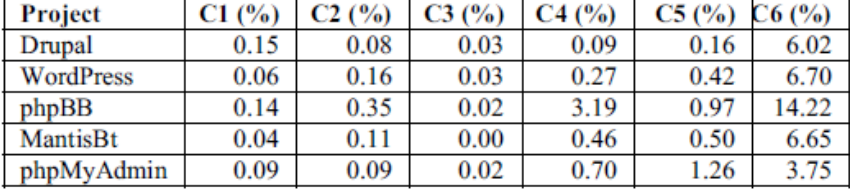
Fig. 3. Ratio of changes in function